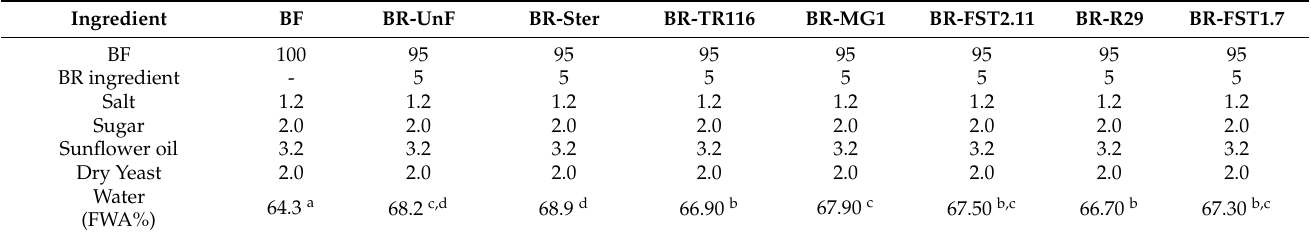
Table 3. Recipes for bread preparation expressed as a % based on flour, which equates to the sum of the baker’s flour (BF) and barley rootlet (BR) ingredients. UnF and Ster represent unfermented and heat-sterilised barley rootlets, respectively. BR-TR116, BR-MG1, BR-FST2.11, BR-R29, and BR-FST1.7 express barley rootlets fermented with their respective LAB strains, namely Leuconostoc citreum TR116, Weisella cibaria MG1, Lactobacillus amylovorus FST2.11, Limosilactobacillus reuteri R29, and Lactiplantibacillus plantarum FST1.7, respectively. FWA % represents results obtained from farinograph water absorption, with letters sharing the same subscript numbers and not significantly differing ( p <